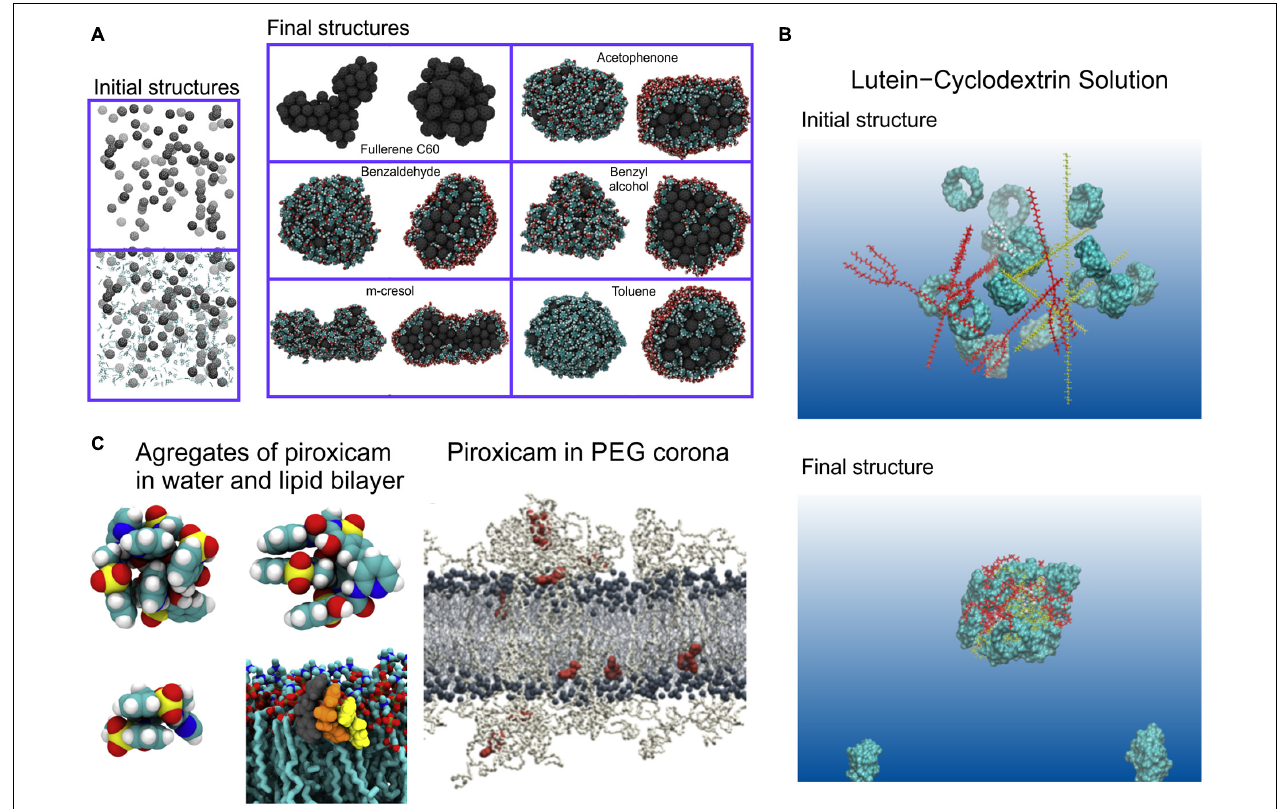
FIGURE 4 | Dissolution and solubility. (A) Formation of clusters of fullerene with organic solvents, for the final structures clusters full view (left side) and its cross section (right side) are shown, organic solvent covers fullerene from outside and are present in small quantities inside the cluster, reproduced from Lehto et al. (2014), Copyright: 2014; (B) formation of lutein and cyclodextrin complexes (Zhao et al., 2018), Copyright (2018) American Chemical Society; (C) Aggregates of piroxicam formed in water and lipid bilayer, and piroxicam molecules dispersed in PEG corona of PEGylated lipid bilayer, reproduced with permission from Wilkosz et al.